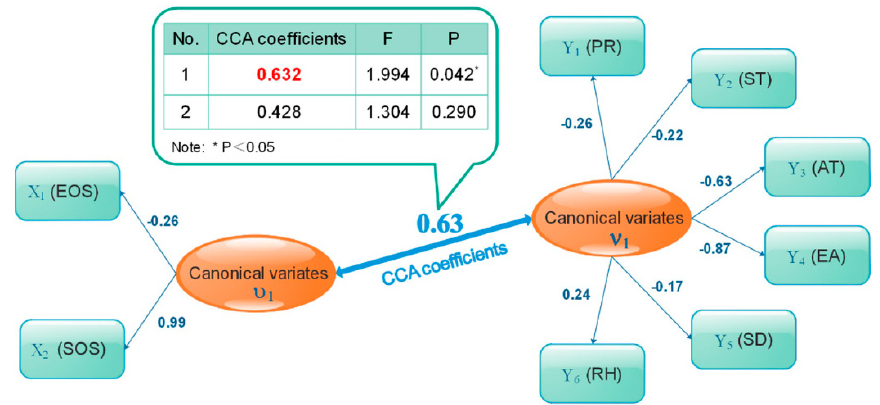
Figure 7. Canonical correlation analysis patterns between phenology (SOS and EOS) and interannual climatic factors (SD, AT, ST, EA, RH, and PR).